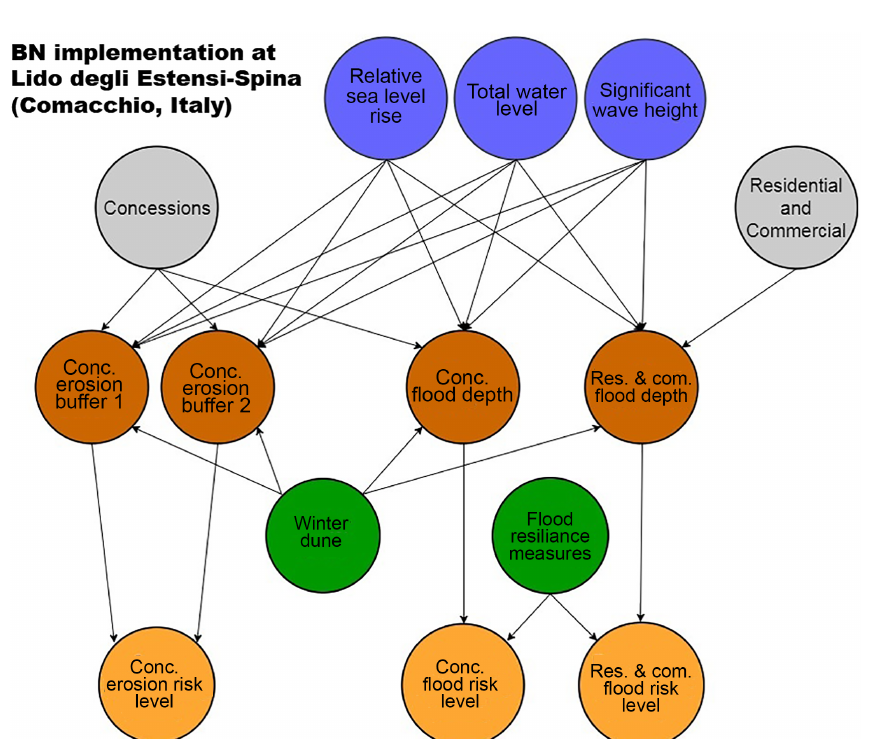
Figure 9. Bayesian network scheme for the Lido degli Estensi–Spina